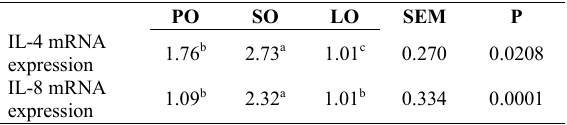
Table 3. The relative IL-4 and IL-8 mRNA expression (fold change) in lambs fed experimental diets.